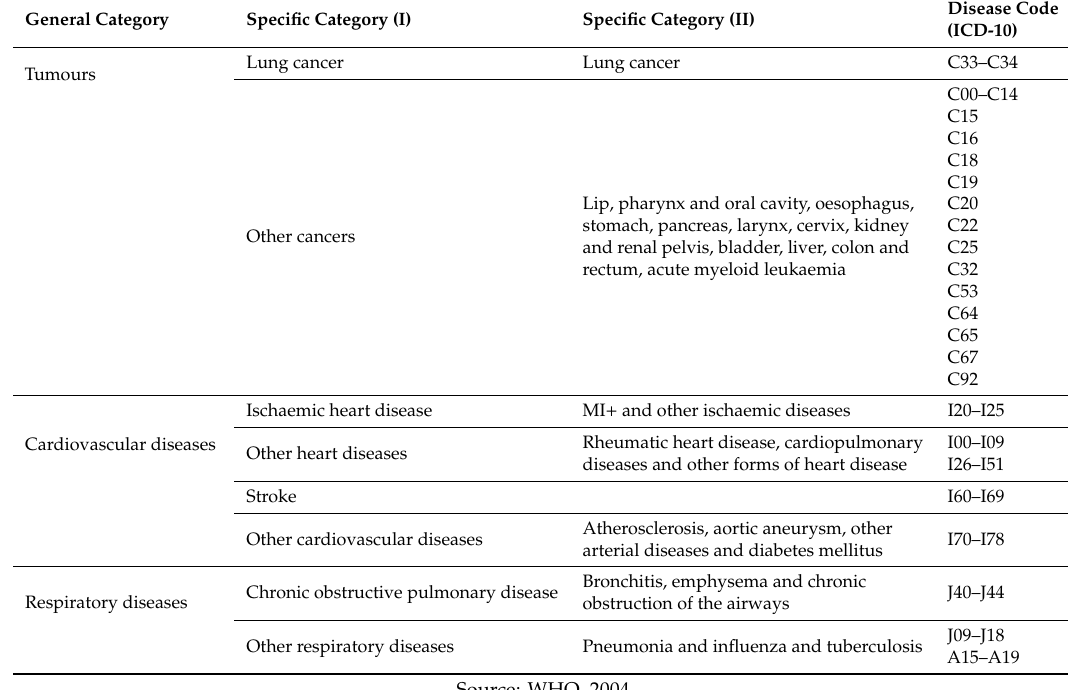
Table A1. Smoking-related diseases considered in the analysis.